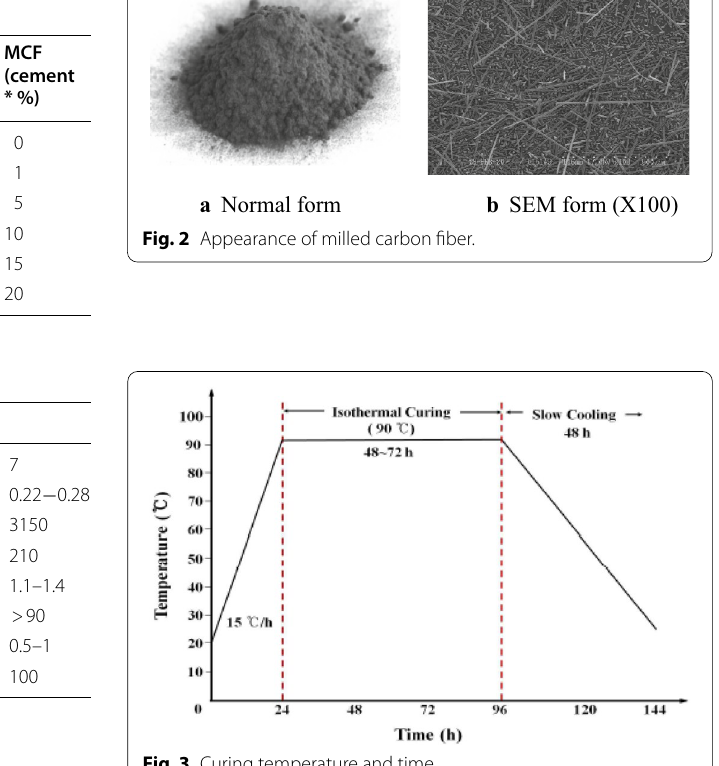
Fig. 3 Curing temperature and